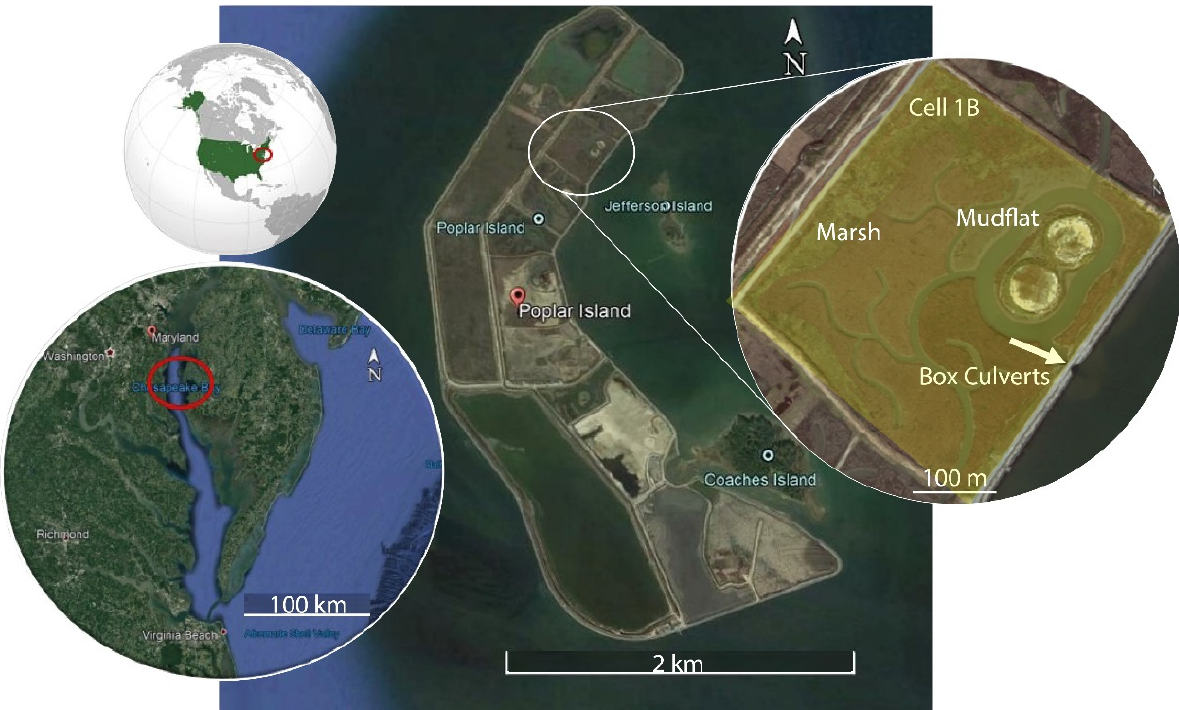
Figure 1. Poplar Island in the upper part of Chesapeake Bay (Maryland, US East Coast). The study site is on Poplar Island is the Cell 1B (highlighted in yellow color in the zoomed plot), in the northern part of the island (images courtesy of Google Earth and U.S. Army Corps of Engineers). Box culverts location shows the tidal inlet connecting the marsh with the Chesapeake Bay.